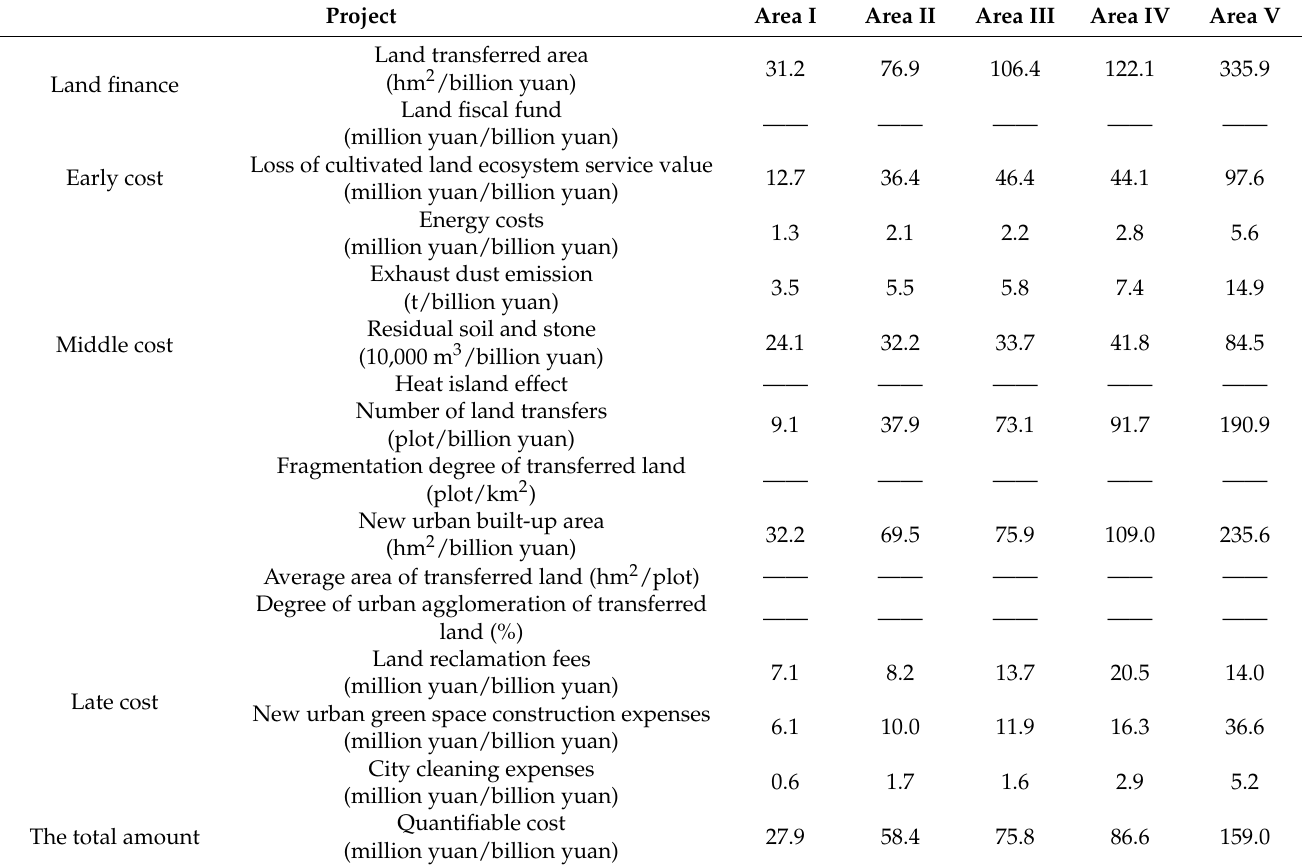
Table 9. Cost of land finance funds per 1 billion yuan in each area from 2003 to 2017.